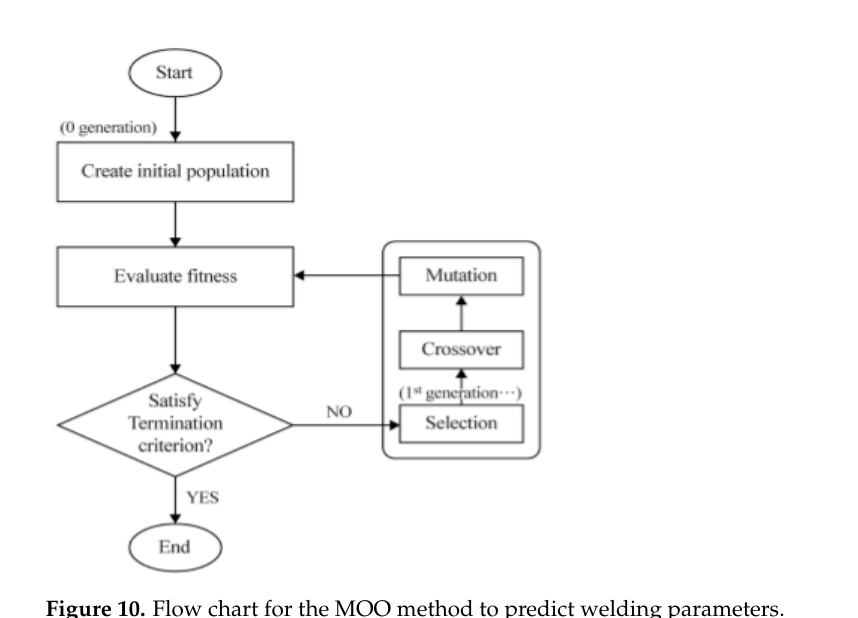
Figure 10. Flow chart for the MOO method to predict welding parameters.